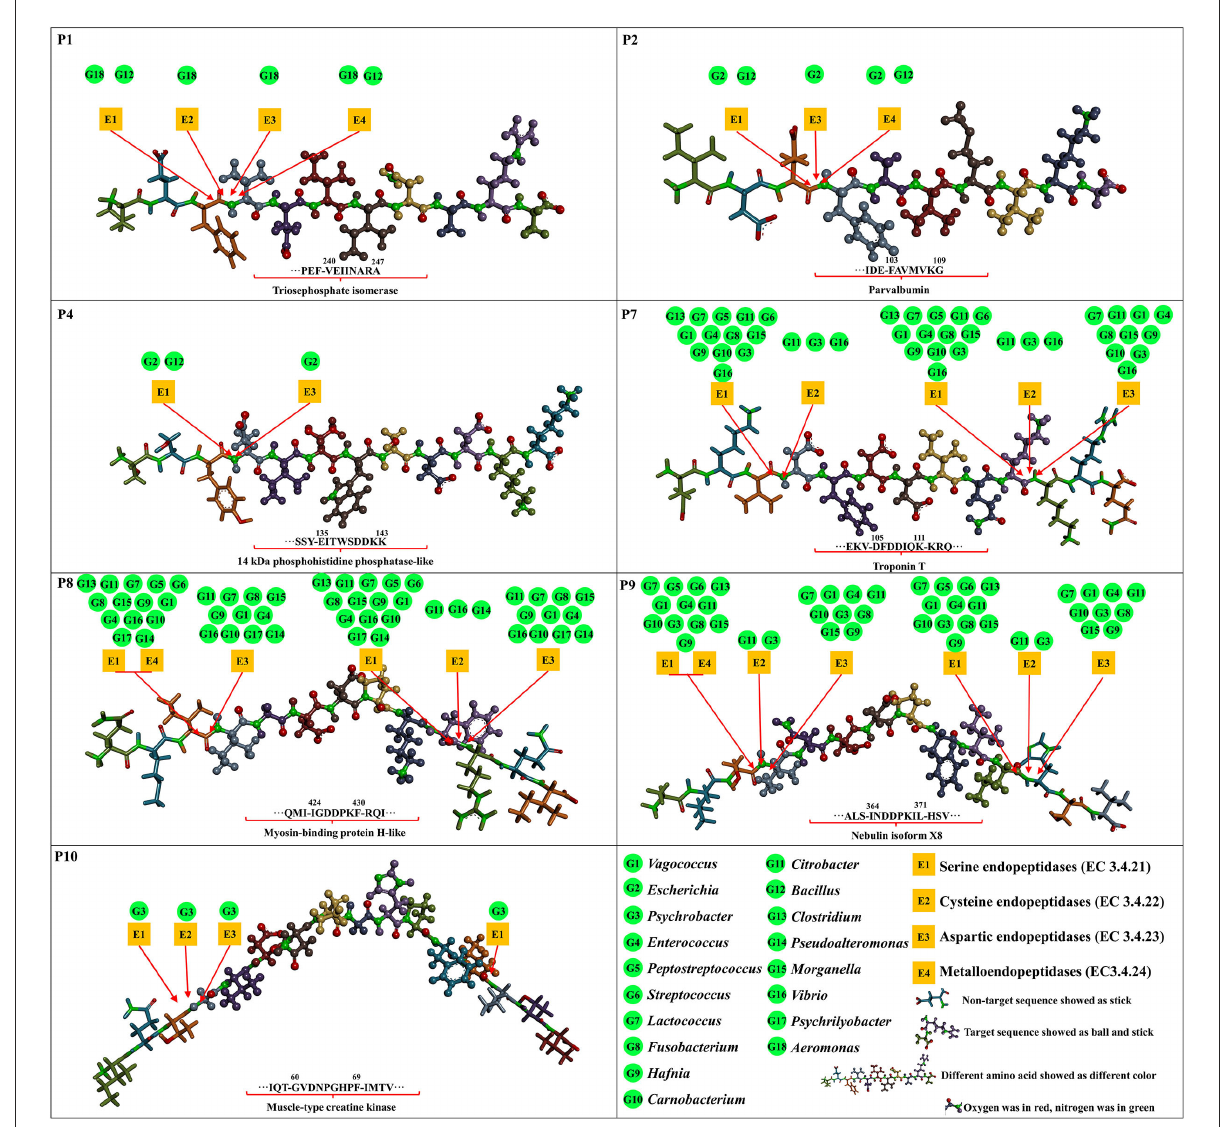
FIGURE6 Formation of the core ACE inhibitory peptides (P1, P2, P4, P7, P8, P9, and P10) through cleavage proteases from the microbial genera based on hydrolysis prediction and correlation network.